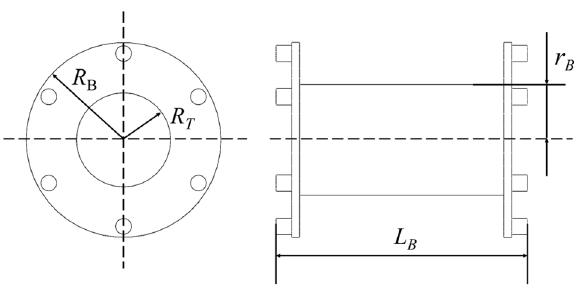
Figure 4. Comparison of the finite element and dynamic models.